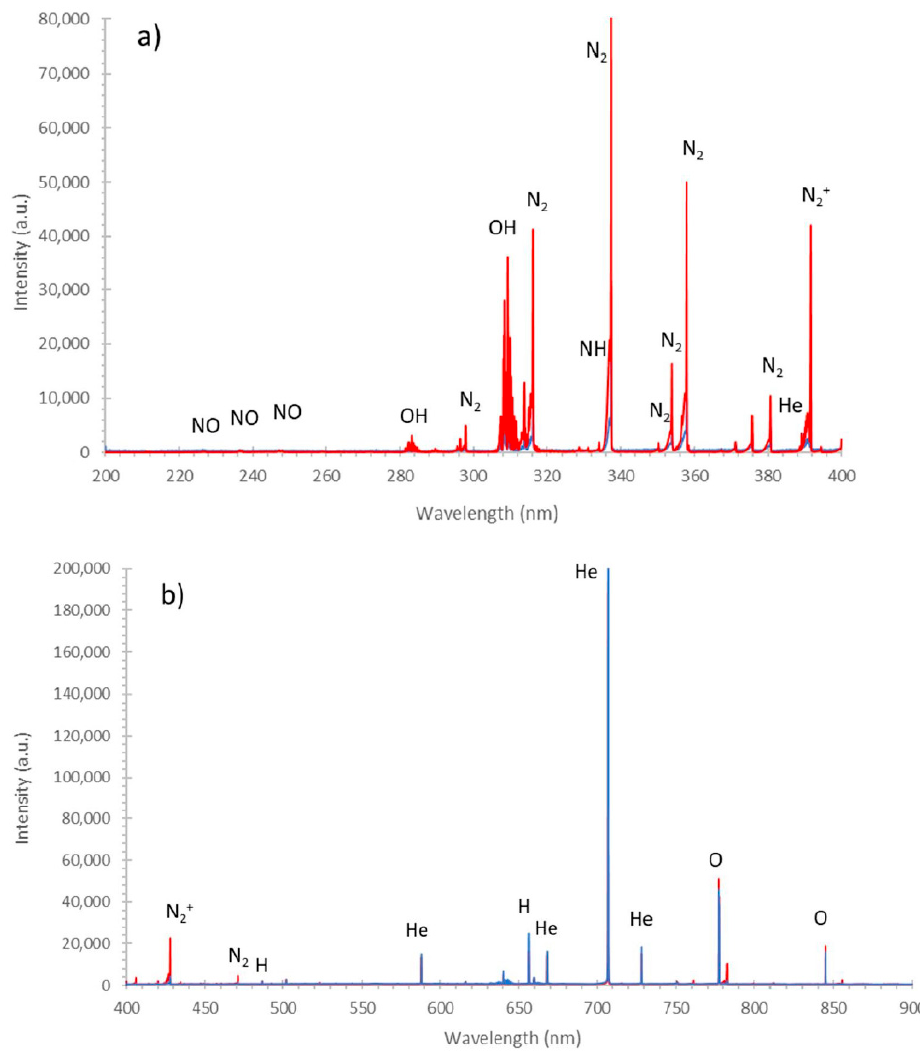
Figure 6. The emission spectra of CAPP generated in contact with the DMEM (red line) and the Opti-MEM (blue line) in the ( a ) 200–400 nm and ( b ) 400–900 nm spectral regions.